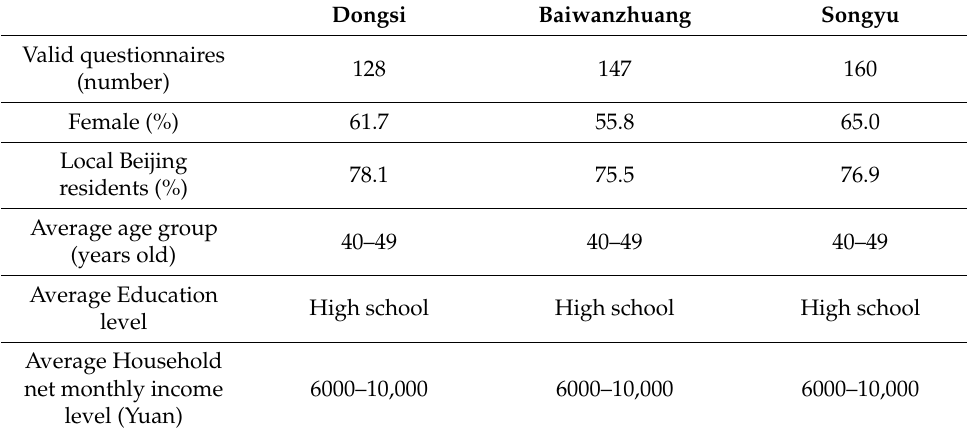
Table 4. Socio-economic status of the three neighborhoods. Dongsi